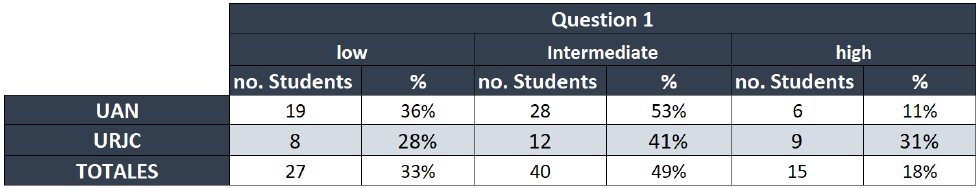
Figure 9. Distribution of responses to Question 1 according to the three grades of reflection (low, intermediate, high) by giving the number of students (no.students) classified and their percentage (%) of the total in their row (UAN, URJC and total).